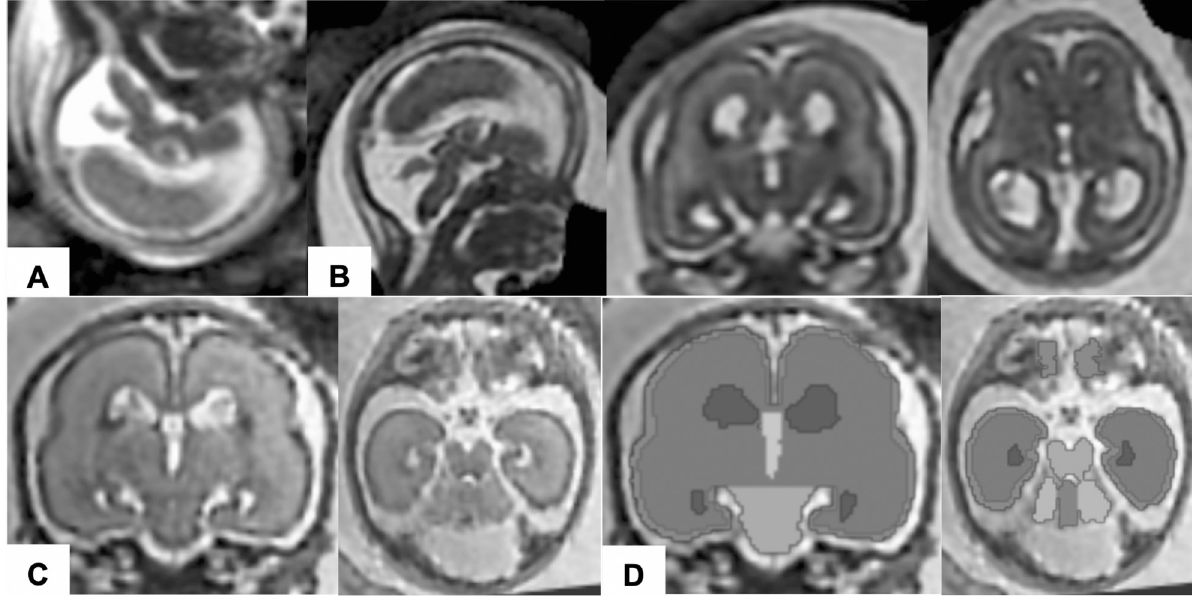
Fig 1. Post-acquisition processing for volumetric analysis of fetal MRI. Raw fetal MR images (A) were processed with motion correction and super- resolution volume reconstruction. The rendered images were then aligned in the same direction along the anterior and posterior commissures (B). In coronal and axial views of the reconstructed volume images (C), regional structures of the brain (i.e., the cortical plate, subcortical parenchyma, cerebellar hemispheres, vermis, brainstem, and lateral, third, and fourth ventricles) were manually segmented on each slice (D).